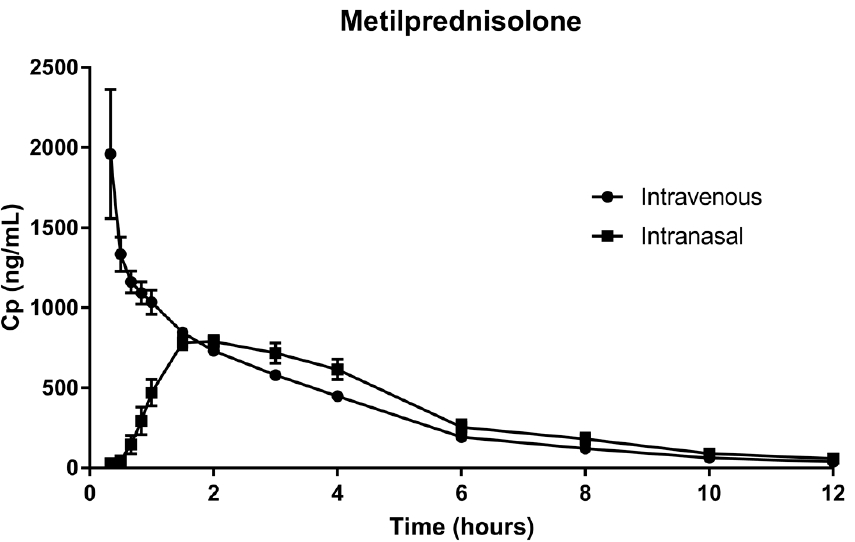
Figure 1. Mean ± SD of the plasma concentration of MEP along time following intravenous or intranasal administration in healthy volunteers.